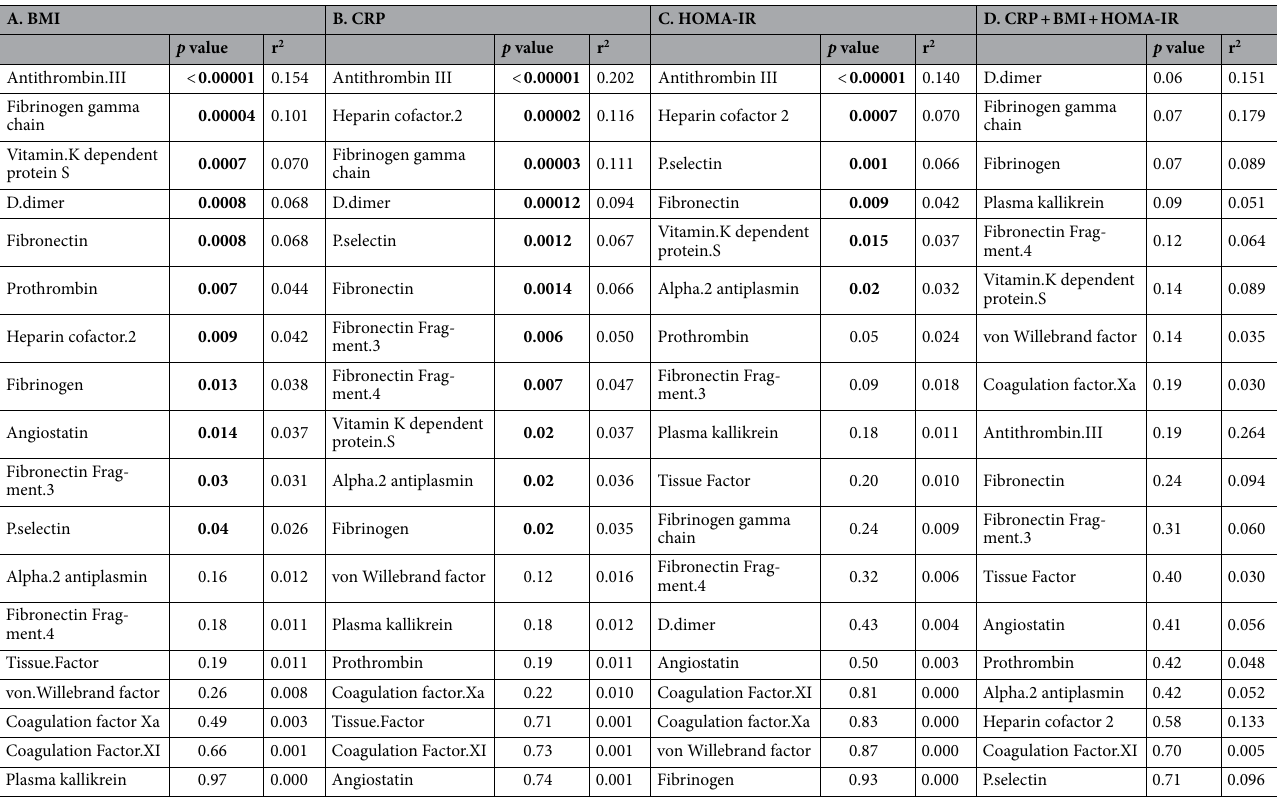
Table 2. Correlation of coagulation proteins with (A) Body mass index (BMI), (B) inflammation (C reactive protein; CRP) and (C) insulin resistance (HOMA-IR), (D) shows the results of the multivariate analysis taking into account BMI, CRP and HOMA-IR. Bolded numbers indicate significant differences between PCOS and control groups, at the p < 0.05